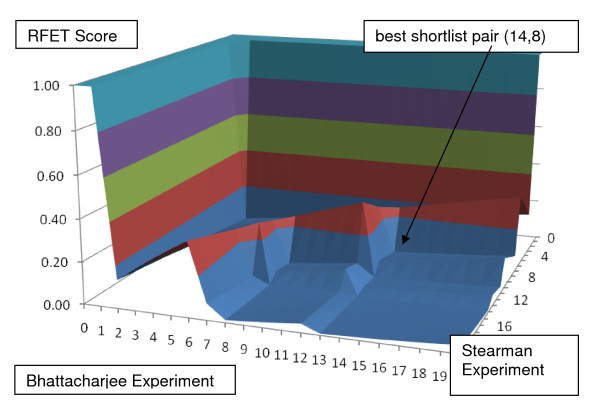
BLANKET applied to comparison of 289 genes within lung cancer microarray studies of Stearman and Bhattacharjee. One pair of shortlists with 14 descriptors from the first and eight from the second yields a RFET score = .0044; this is less than .0066, the level that insures a p-value significance level (.05) for any shortlists with twenty or fewer members from a universe of 300 members.